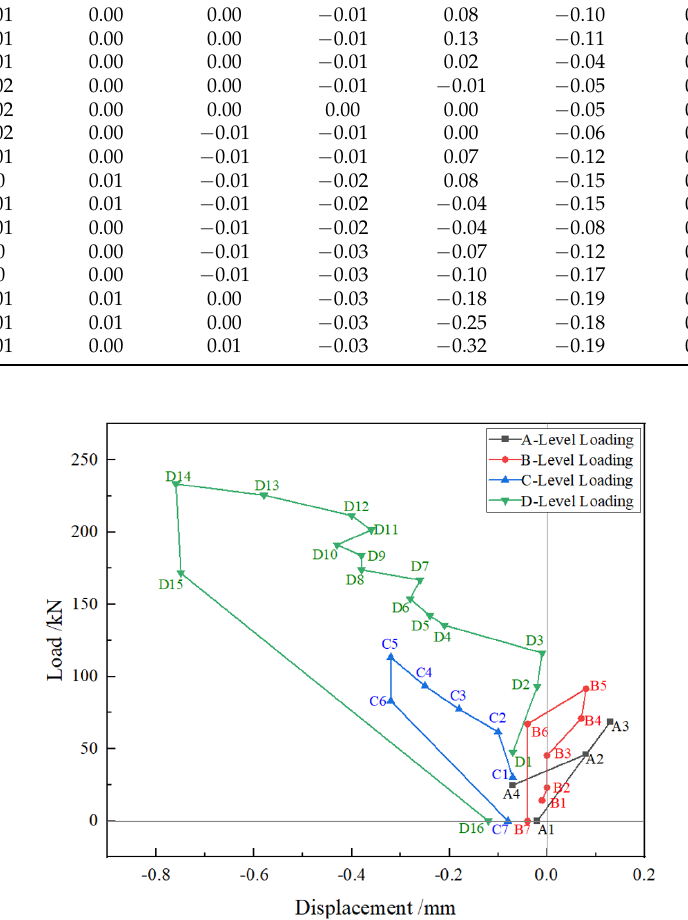
Figure 12. Load-displacement curve of vault.